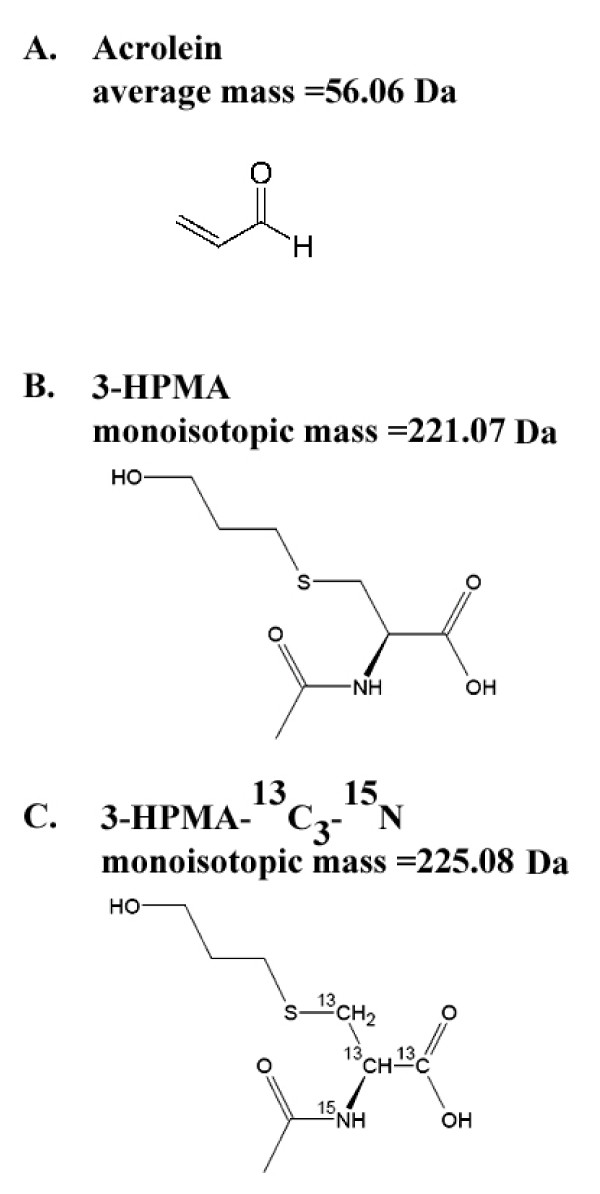
Chemical structure of acrolein (A), 3-HPMA (B), and 3-HPMA-13C3-15N (C). 3-HPMA and 3-HPMA-13C3-15N molecular weights are also indicated.